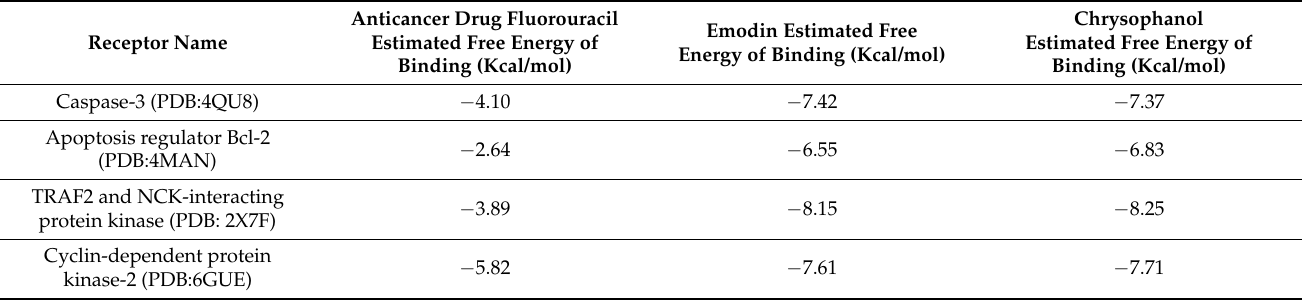
Table 4. Comparative analysis of data obtained after docking with emodin and chrysophanol and FDA-approved anticancer drug